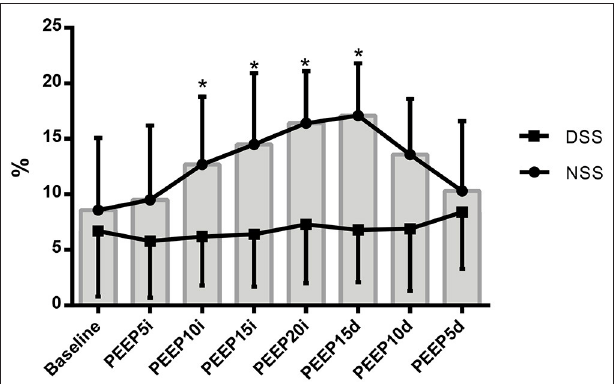
FIGURE 1 | Variation of the NSS (closed circle) and DSS (closed square) regions of lung represented by mean ± standard deviation during recruitment maneuver for PEEP titration. NSS, nondependent silent space; DSS, dependent silent space. PEEP5i, PEEP 5 cmH 2 O increase; PEEP10i, PEEP 10 cmH 2 O increase; PEEP15i, PEEP 15 cmH 2 O increase; PEEP20i, PEEP 20 cmH 2 O increase; PEEP15d, PEEP 15 cmH 2 O decrease; PEEP10d, PEEP 10